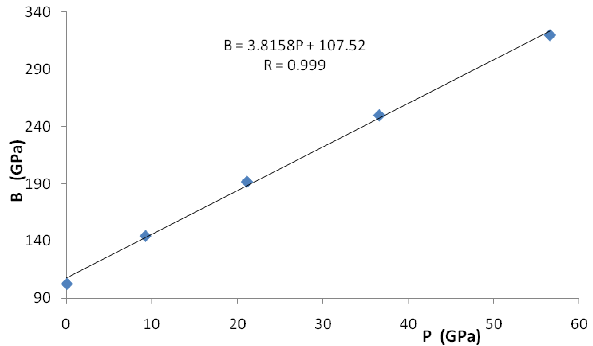
Fig.1 Fig. 1. The pressure dependence of isothermal bulk modulus B at